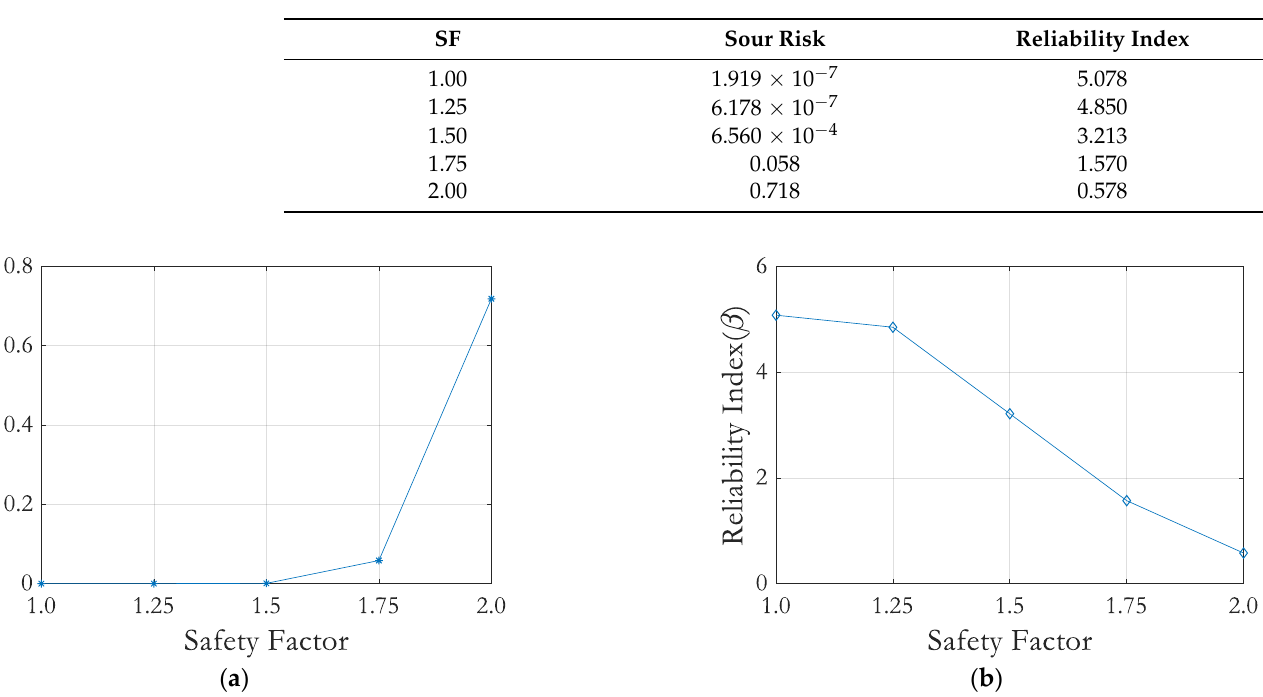
Table 3. Scour risk and reliability index.